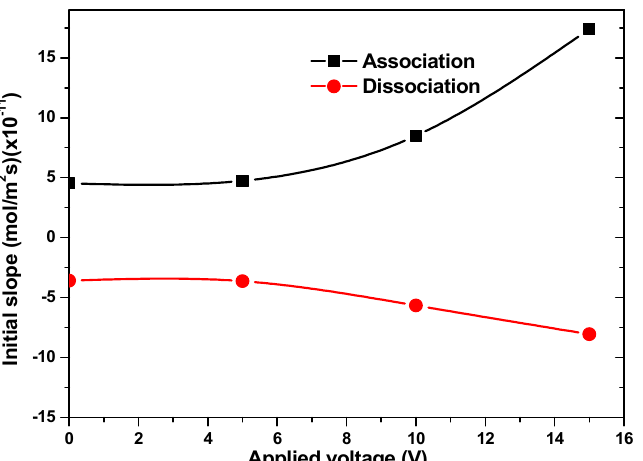
Figure 9. Initial slope related to association and dissociation phases of CRP complex versus the applied voltage. The average inlet velocity is fixed at 100 µ m/s. The value of initial slope is calculated by choosing few of the initial points from the curves of Figure 8 then a linear interpolation by the least square method is used to compute the slope.